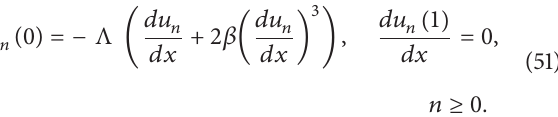
Figure 2: Geometry of the drainage